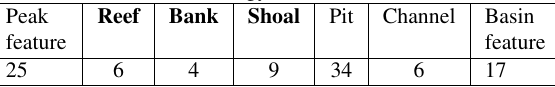
Figure 9: Results of undersea feature characterisation Table 1: Undersea features classified from Figure 9. Features defined in the IHO terminology in bold.